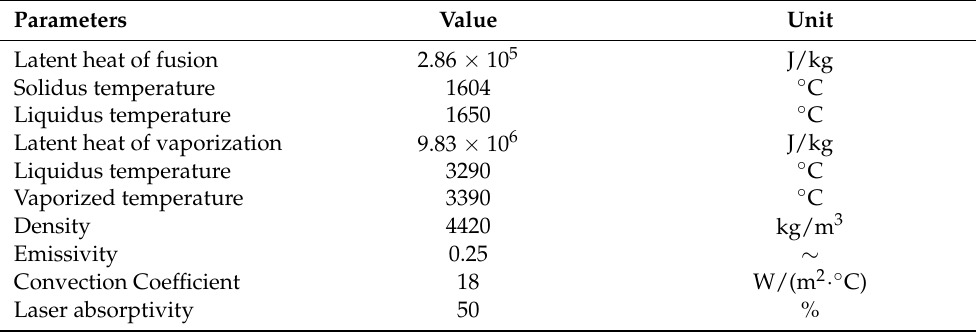
Table 2. Latent heat of Ti-6Al-4V